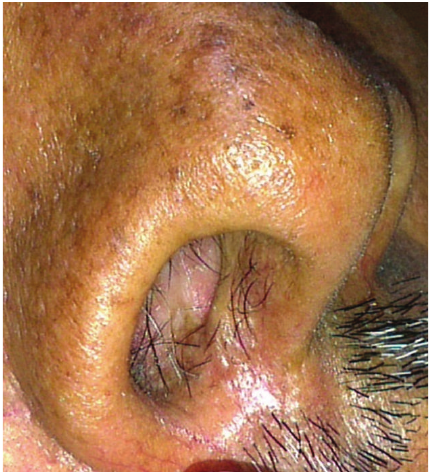
Figure 6: Healed nasal sinus tract with no signs of recurrence at 1